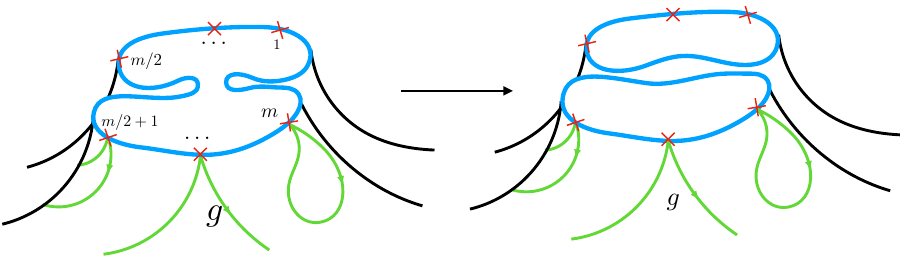
Figure 24 . The action of deforming the n boundaries of Σ into two 2 n new